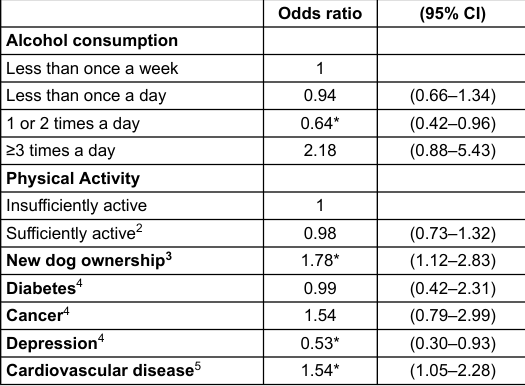
Table 3: Estimated independent associations of smoking cessation between SAPALDIA2 (2002) and SAPALDIA3 (2010/11) with different personal characteristics newly introduced in SAPALDIA2 1 .